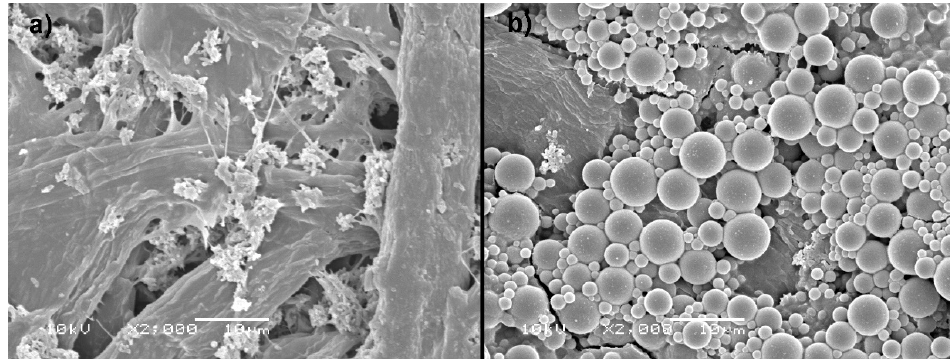
Figure 7. SEM of Prime Jet 80 paper samples: ( a ) uncoated , ( b ) coated. In the case of the handsheets from subsequent recycling cycles (Figure 8), a small fraction of the spherical organosilicon objects remains permanently bound to the fibers, as they are also visible in the SEM images of the samples before coating. Although there are not enough of them to impart hydrophobic properties to the surface, it explains the decrease in water intake in Cobb 120 s measurements visible in the uncoated set of sam- ples in Figure 5a.